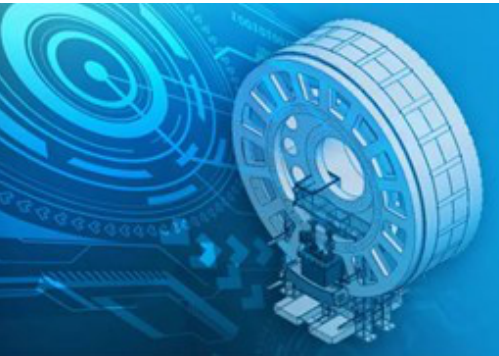
Fig.8 The concept of EcoSwing. Reproduced from